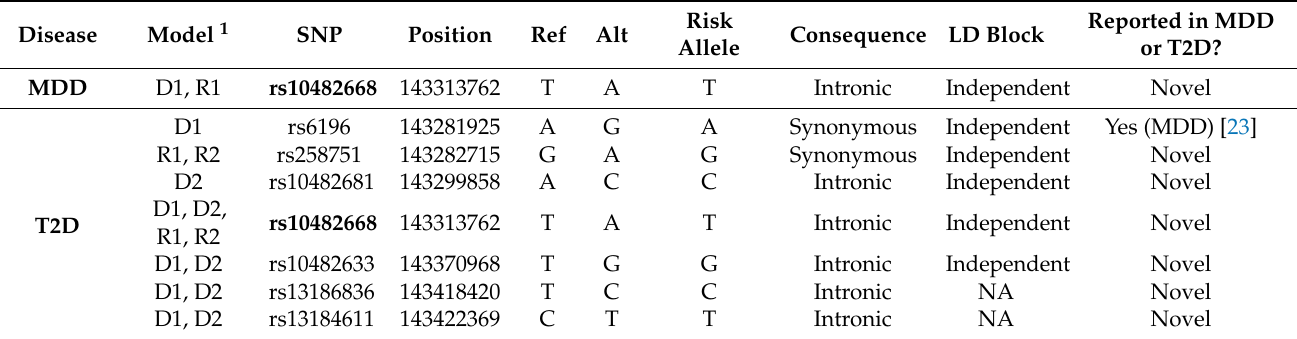
Table 1. Risk single nucleotide polymorphisms in NR3C1 gene linked/in linkage disequilibrium to/with major depressive disorder and/or type 2